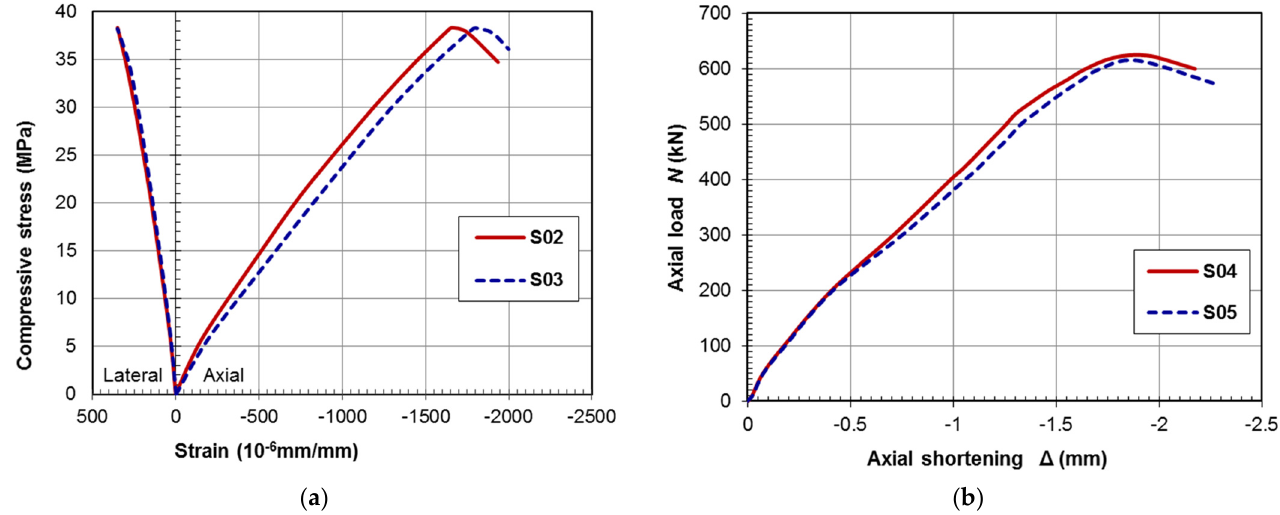
Figure 5. Measured axial load versus strains ( a ) and load versus deformation ( b ) relationships of plain reinforced concrete specimens (S0x series).